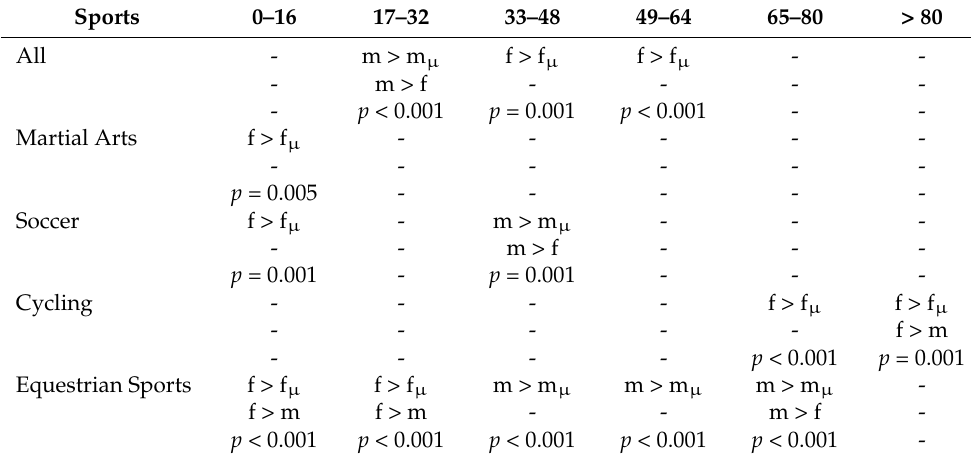
Table 2. Bonferroni-corrected significant sex differences split by sport and age group, expected value female/male ( w / m ).